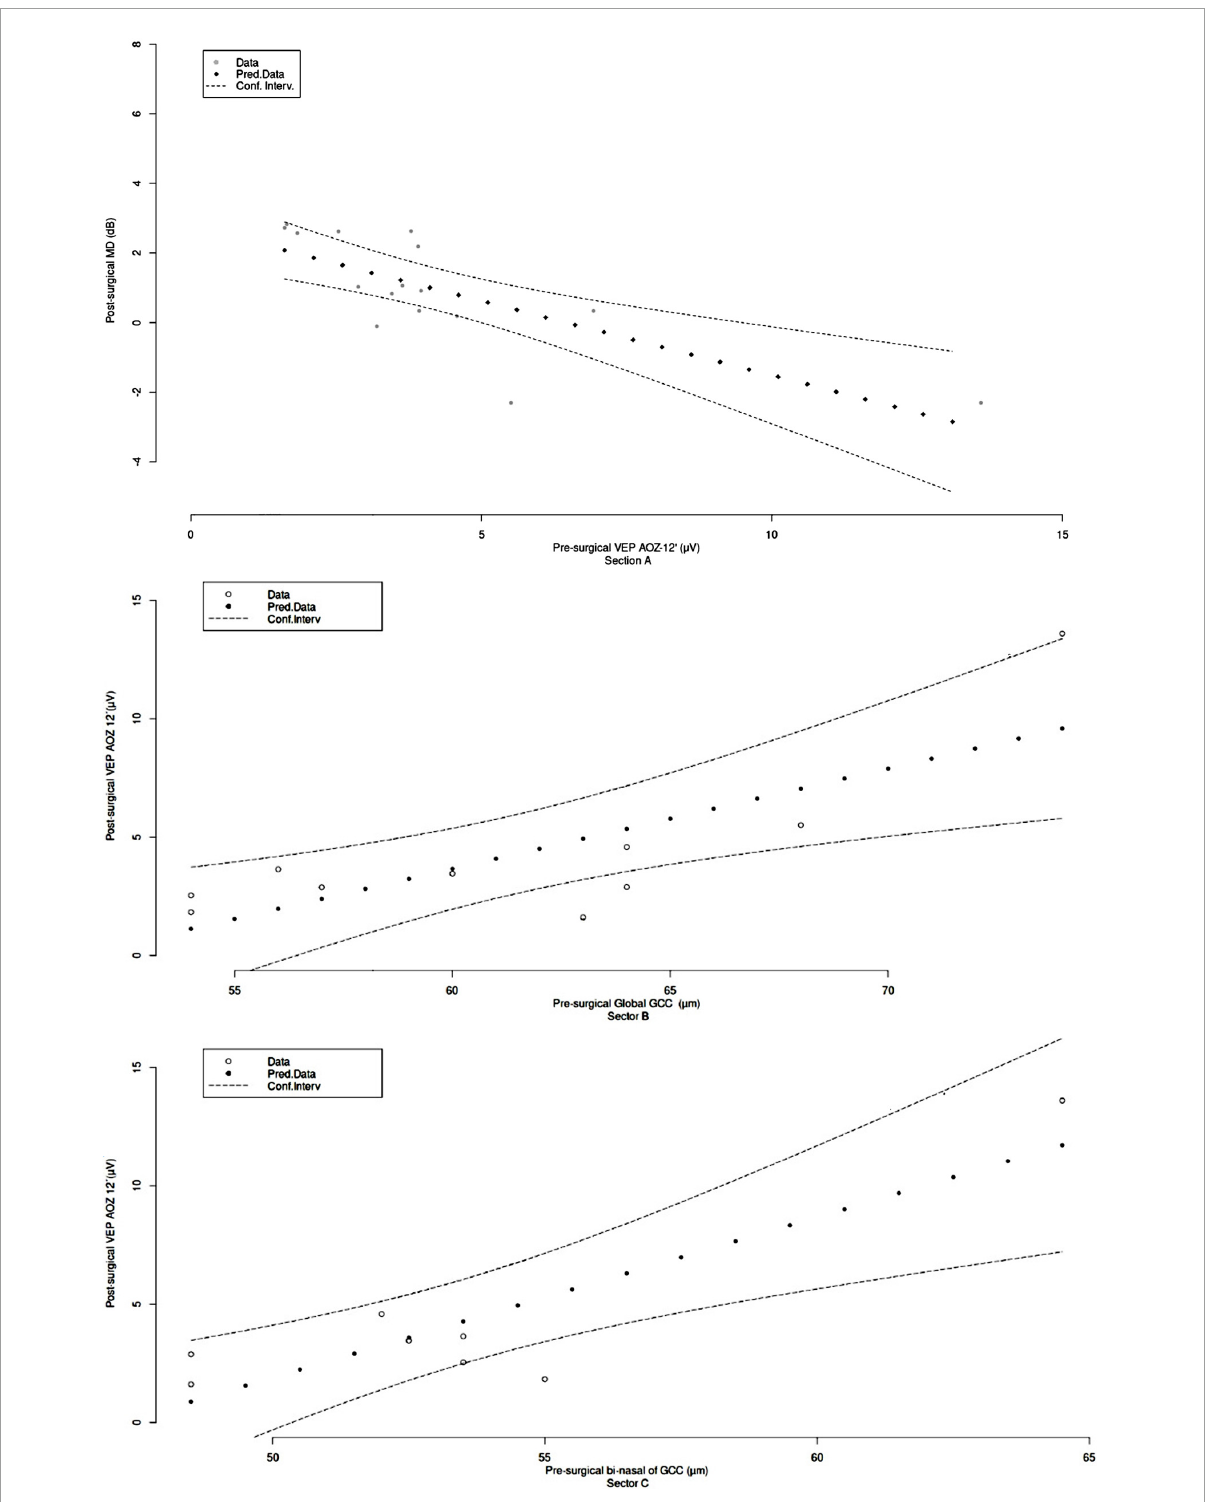
FIGURE4 Predictive value of structure/function biomarkers in pituitary macroadenoma patients’ vision recovery. (Section A) Pre-surgical visual evoked potential amplitude Oz 12 (cid:48) (X) vs. 3 months post-surgical visual field median deviation (Y), Y = 23 e − 0 , 8 x ; r 2 = 0.62. (Section B) Pre-surgical global ganglion cell complex (X) vs. 3 months post-surgical visual evoked potential amplitude OZ 12 (cid:48) (Y), Y = 0.14 x – 8.4; r 2 = 0.54. (Section C) Pre-surgical bi-nasal of ganglion cell complex (X) vs. post-surgical 3 months visual evoked potential amplitude OZ 12 (cid:48) (Y), Y = 0.21 x – 9.1; r 2 =